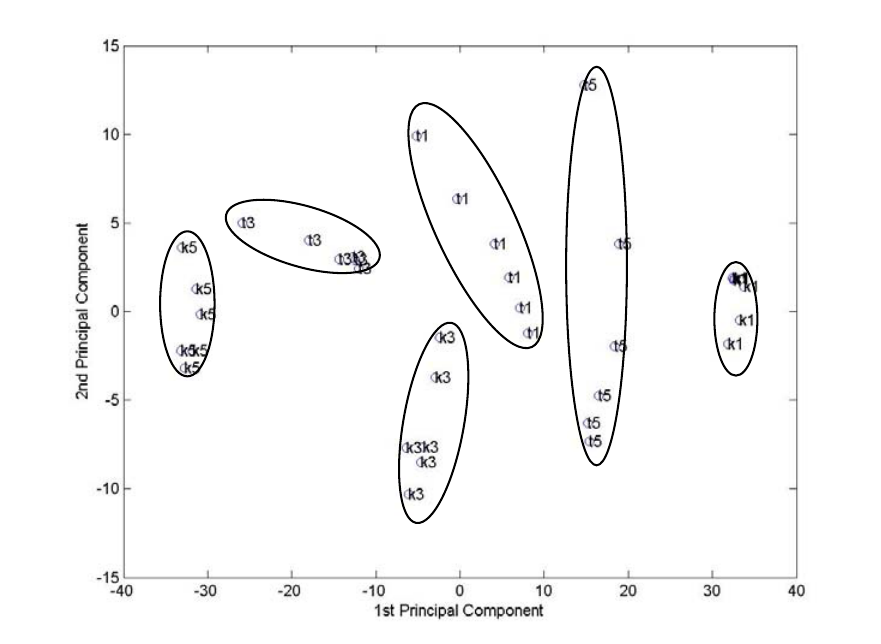
Figure 3. PCA score plot of the original anodic wave of copper electrode in six Chinese yellow wines mixed with 1 M NaOH solution. The potential range: -0.1 V to 0.3